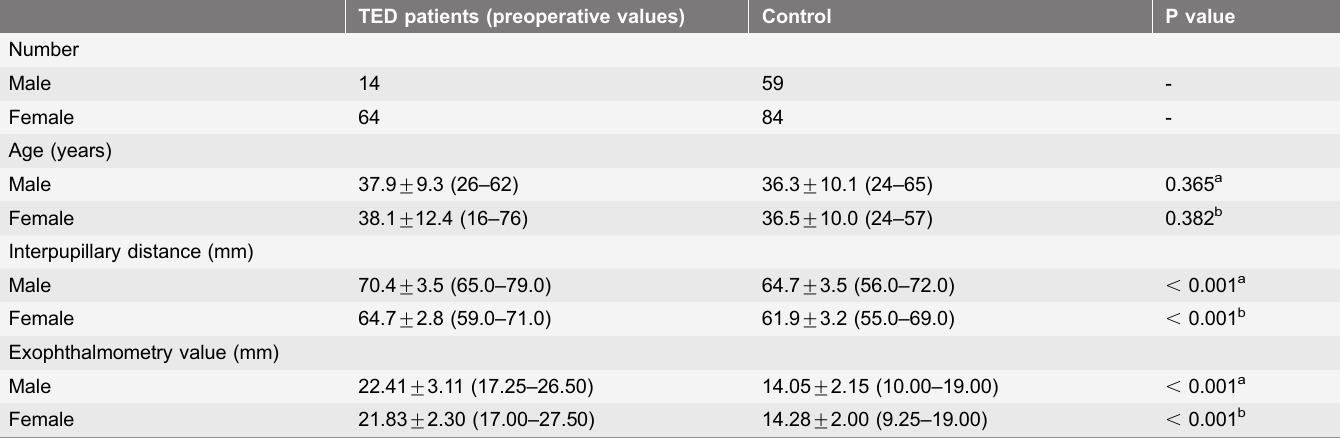
Table 1. Summary of patient data, measurement results, and statistical comparisons between preoperative measurement values in thyroid eye disease (TED) patients and measurement values in controls. TED patients (preoperative values) Control P